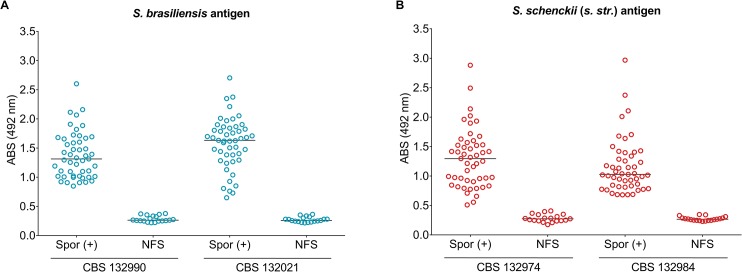
ELISA of antibody titers in sera from cats (n = 49) with confirmed sporotrichosis (Spor +).The range of antibody titers against S. brasiliensis (A) and S. schenckii s. str. (B) antigens were expressed as optical density (absorbance). Each symbol represents an individual cat; horizontal lines indicate the mean. Data are representative of two independent experiments. Titers from the control group (NFS: non-feline sporotrichosis) were significantly lower (P<0.001) than titers from infected cats (Spor +). Further information about ELISA statistics appears in S1 Table.